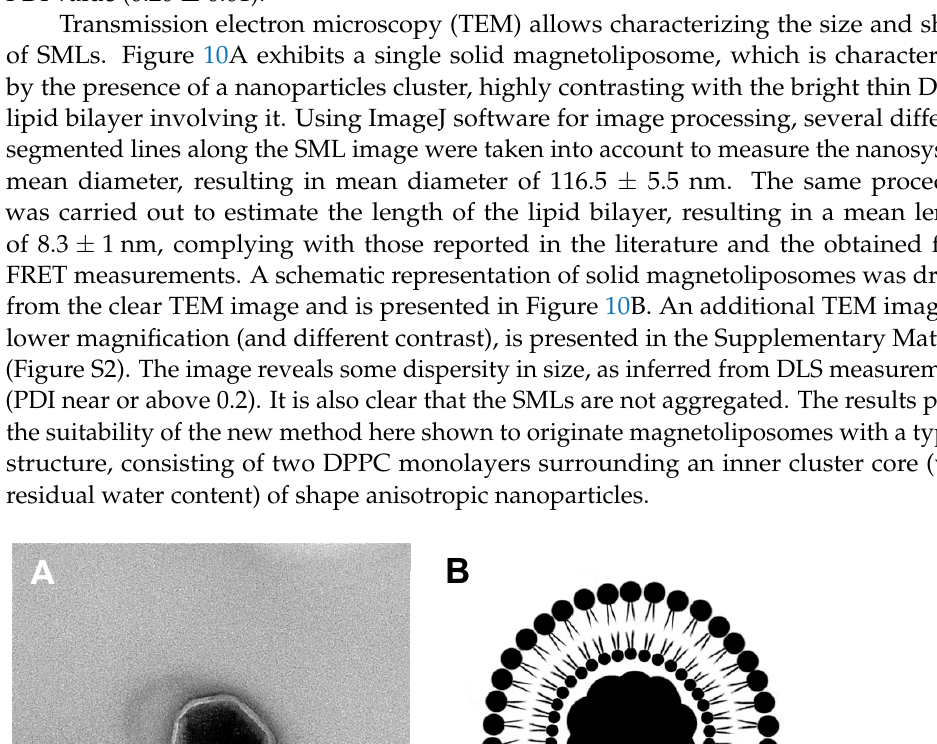
Table 3. Hydrodynamic diameter (D H ) and polydispersity (PDI) at 25 °C. Results as mean ± SD. SMLs Lipid Formulation